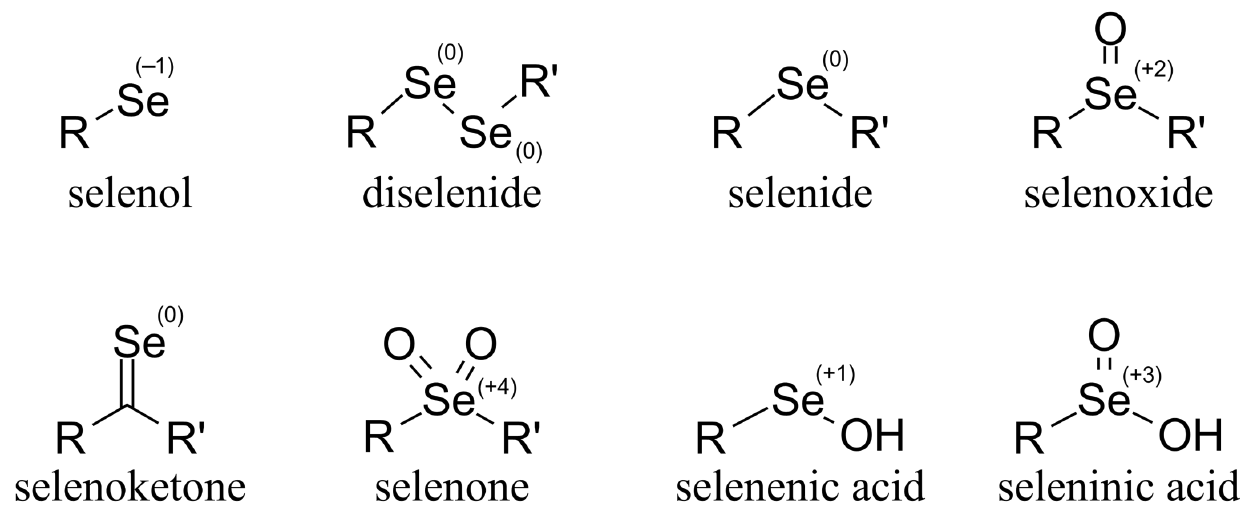
Figure 1. Some examples of organoselenium compounds, with the oxidation number of selenium in brackets. in